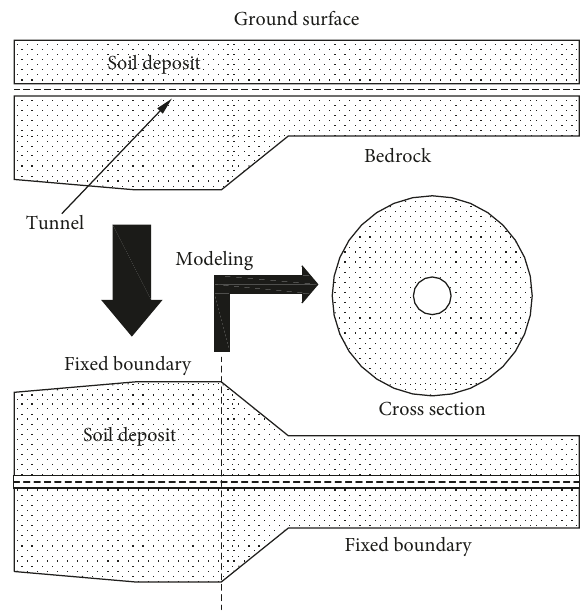
Figure 3: Schematic illustration of axisymmetric modeling.